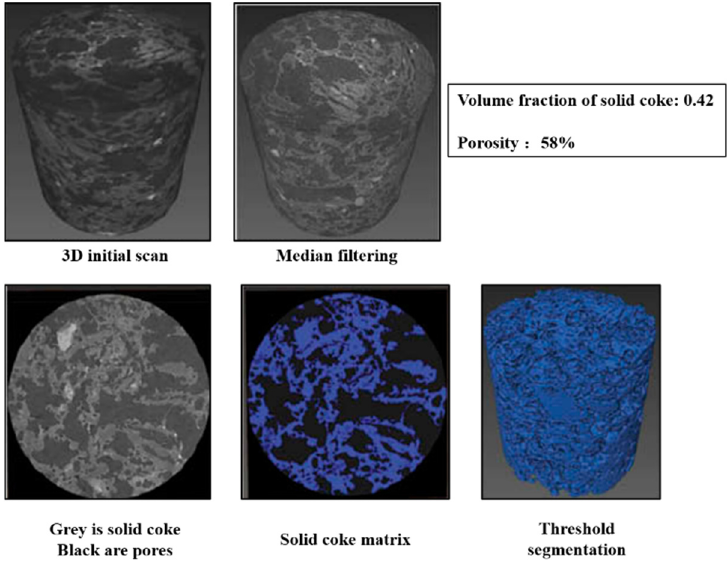
Figure 12. The pore distribution of coke samples in X-ray imaging [80].